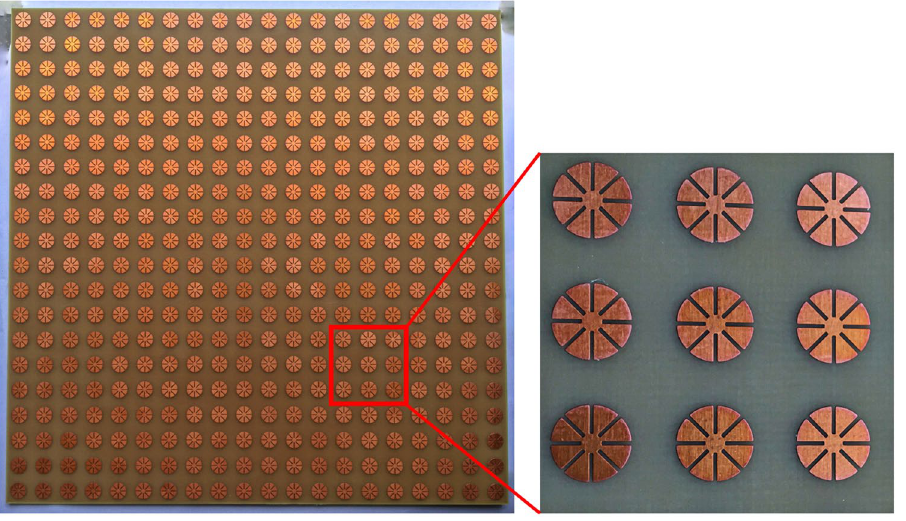
Figure 5. Fabricated metamaterial absorber